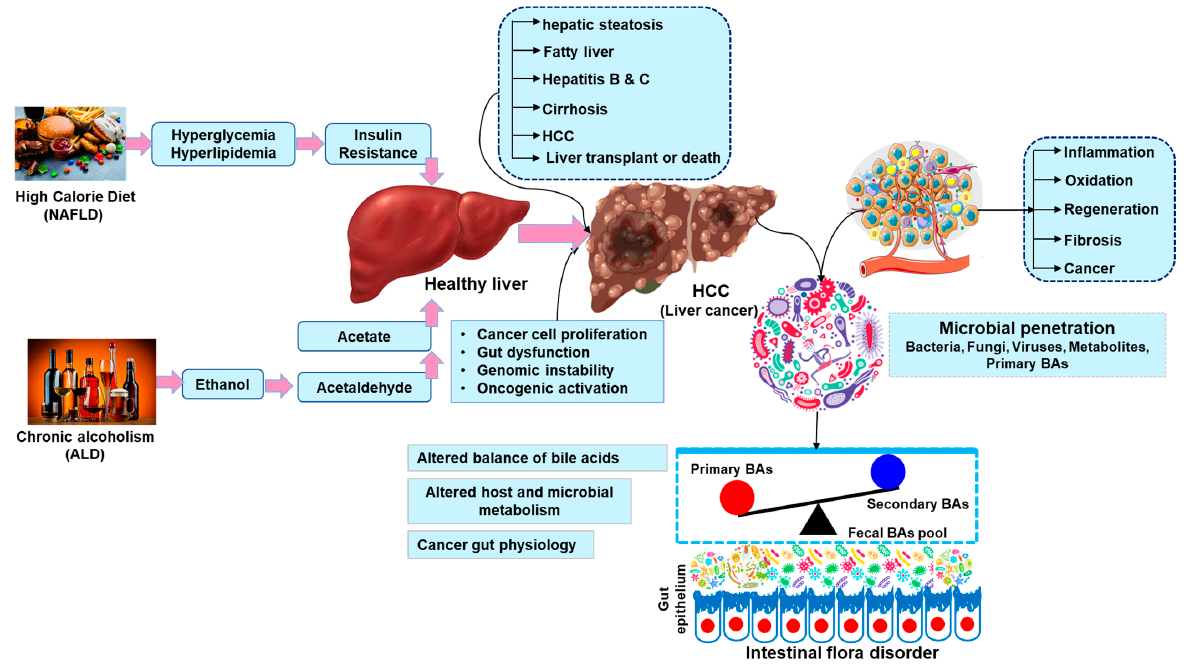
Figure 3. Molecular processes connected to both alcoholic and nonalcoholic HCC. The main risk factors for the development of NAFLD and AFLD, respectively, are a high ‐ calorie diet and excessive alcohol intake. The clinical spectra of liver damage in supporting HCC development in NAFLD and AFLD have comparable molecular mechanisms despite the diverse pathogenic genesis. Within the intestinal tract, microbe ‐ dependent reactions transform primary bile acids into secondary bile acids. An initial piece of evidence that a gut microbe may influence liver cancer was dis ‐ covered in mice that had spontaneously acquired Helicobacter hepaticus (H. hepaticus) in ‐ fections. The H. hepaticus infection has been linked to chronic hepatitis and fibrosis in male BALB/c mice. The H. hepaticus is a spiral bacterium that also lives in the bile canaliculi, the cecal mucosa, and the colonic mucosa and causes chronic active hepatitis and liver tumors. The H. hepaticus is the prototypical carcinogenic bacteria for mice, and experimental infec ‐ tion has already been employed as a model of microbial tumor promotion in the liver